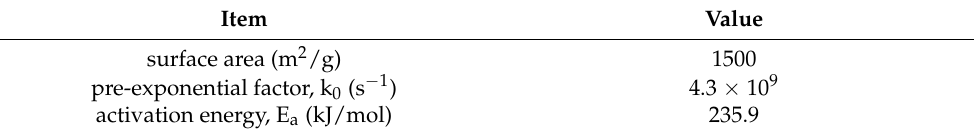
Figure 8. Difference in activation energy w/wo catalyst. Table 1. Properties of BP-2000